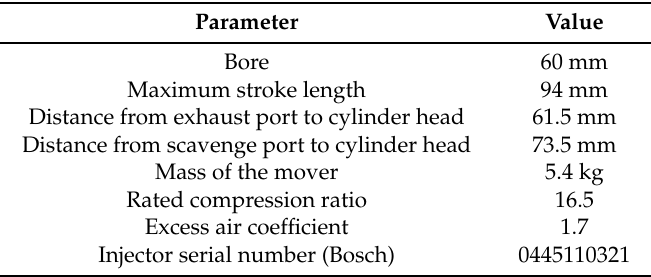
Table 1. Specifications of the FPLG.